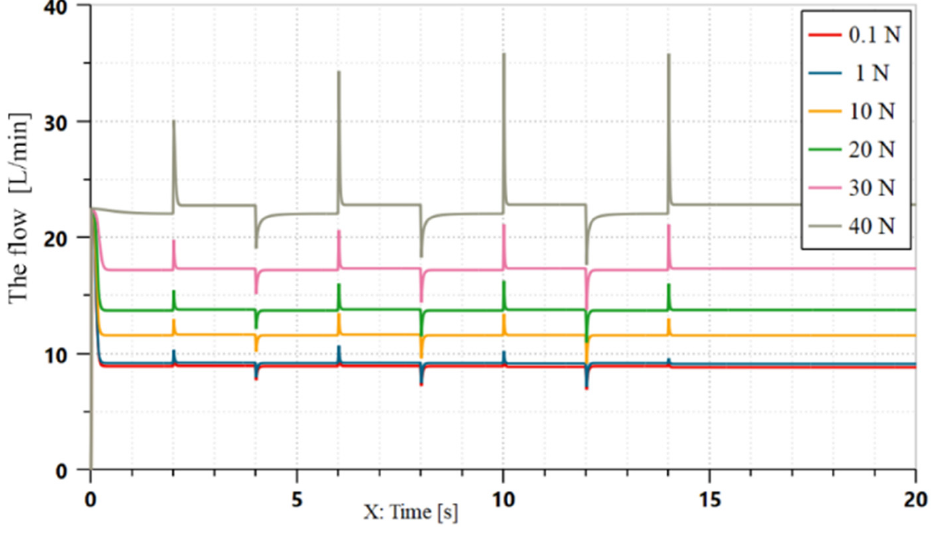
Figure 12. Relationship between spring preload and flow-rate fluctuation.